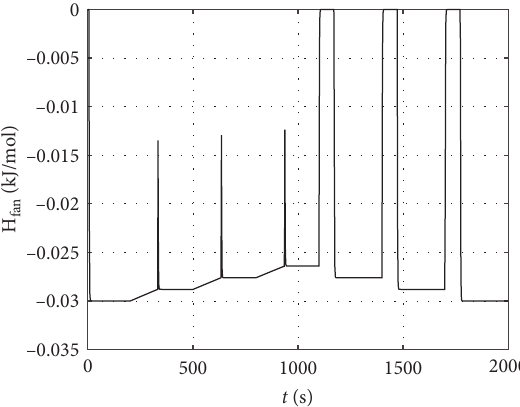
Figure 9: Simulation profile of the cooling energy by fan 1.